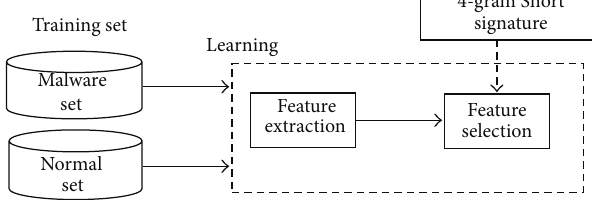
Figure 2: Learning process incorporated by known malware signa- tures.